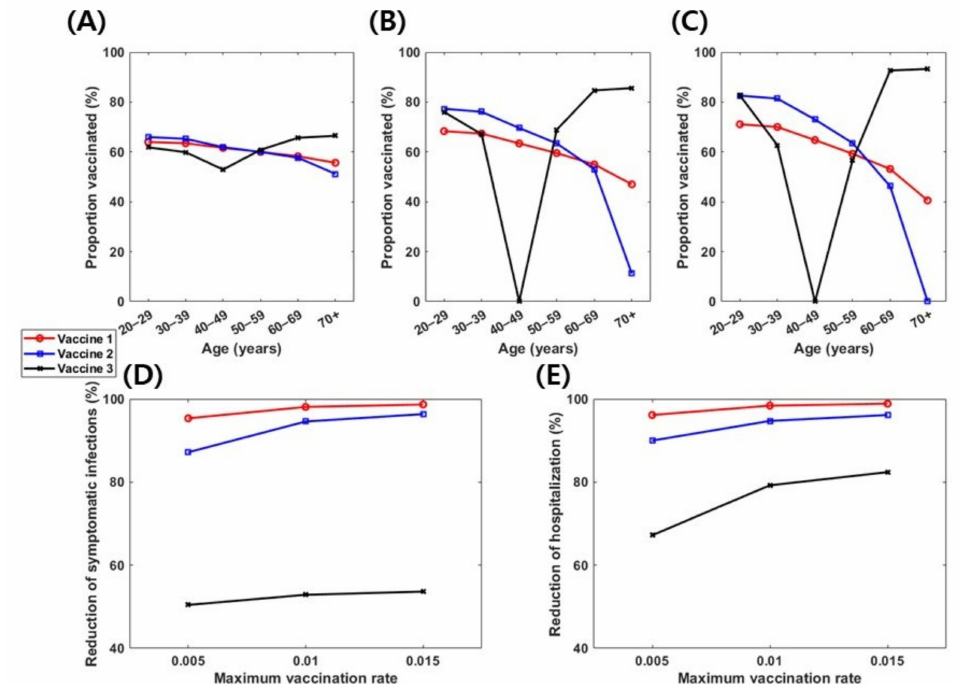
Figure 6. Effect of vaccine rollouts on optimal vaccination strategies. ( A – C ) Age-specific optimal vaccination coverage levels in various vaccine efficacy profiles (1, 2, and 3) with ψ max = 0.005 ( A ), 0.01 ( B ), and 0.015 ( C ). ( D ) Corresponding proportion of reduction in symptomatic infections relative to cases without vaccination. ( E ) Corresponding proportion of reduction in hospitalization relative to cases without